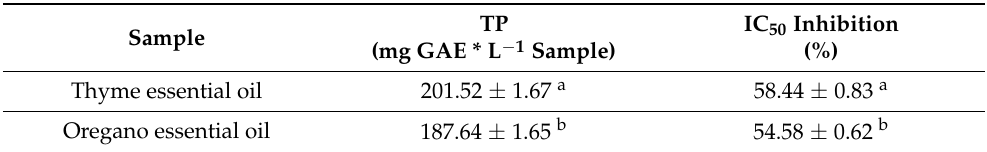
Table 1. Total phenolic (TP) and radical scavenging activity of thyme and oregano essential oil (mean ± SD, n = 3).